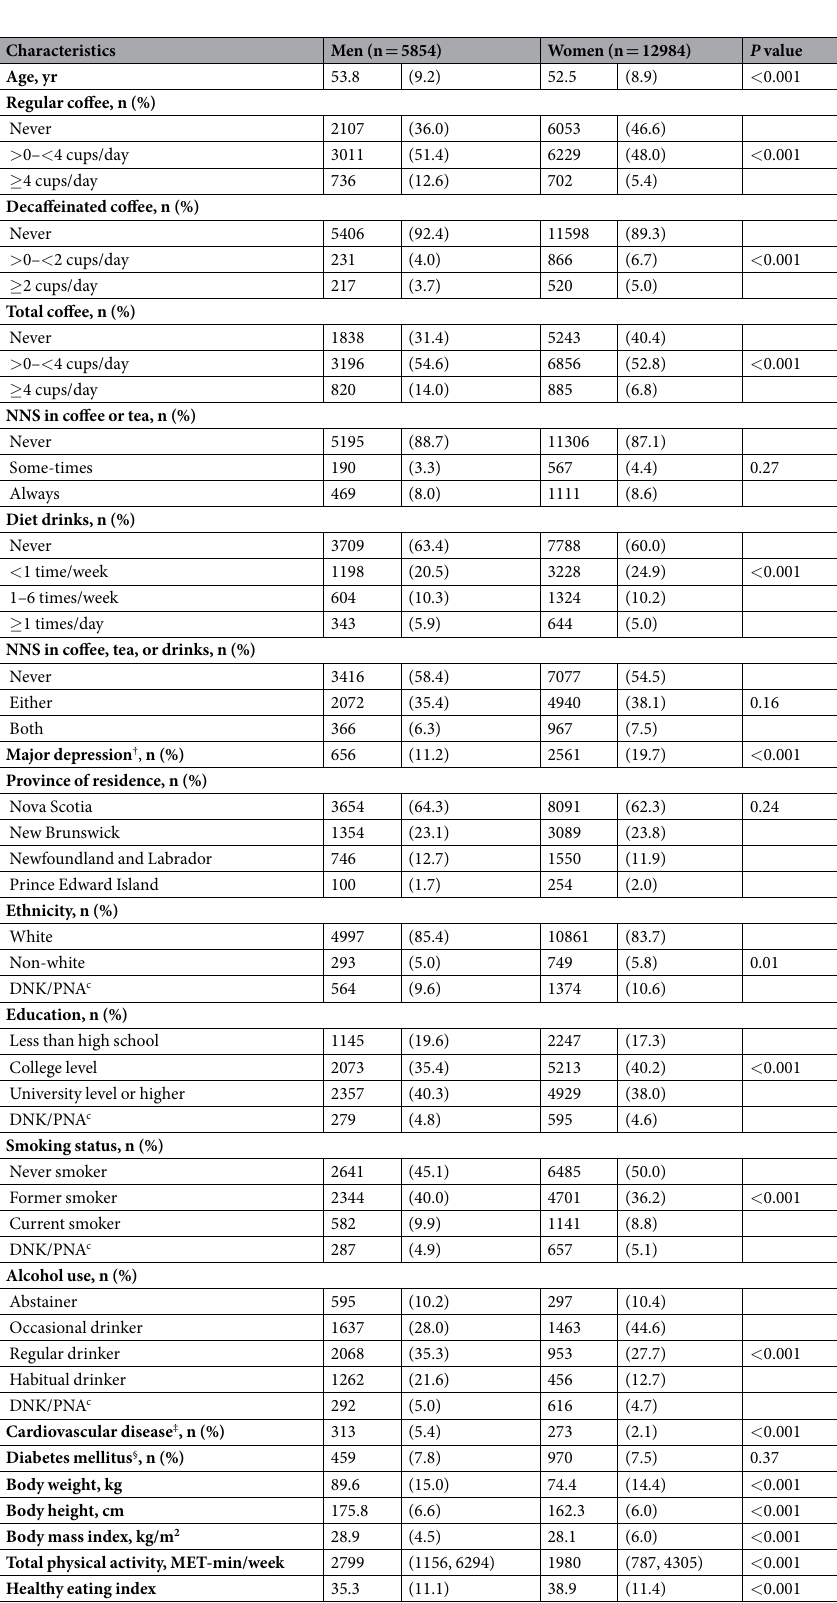
Table 1. General characteristics of study participants by gender * . DNK/PNA = do not know/prefer not to answer; NNS = non-nutritive sweetener. * Data are means (standard deviation), number of participants (percentage), or median (interquartile range). Percentages may not total 100 due to rounding. The numbers of participants vary slightly among different variables. † Defined as a PHQ-9 score ≥ 10 and/or current use of antidepressant. ‡ Self-reported coronary heart disease and/or stroke. § Self-reported diabetes